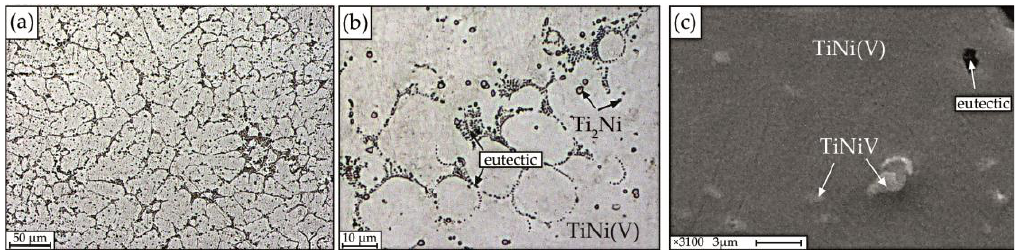
Figure 6. Microstructure of alloy No.1 obtained on optical ( a , b ) and scanning electron microscopes ( c ).